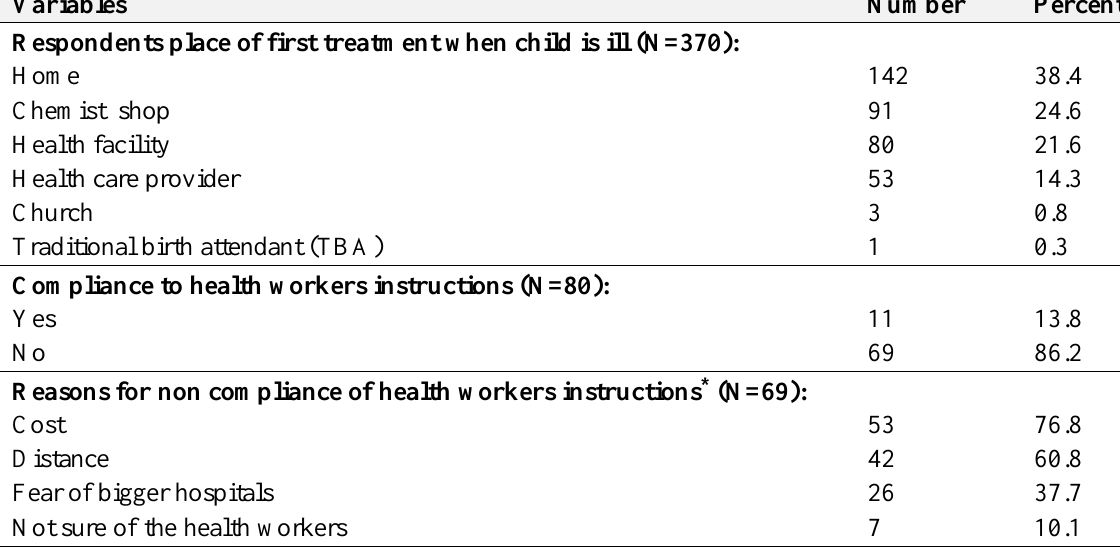
Table 4. Health seeking practices among